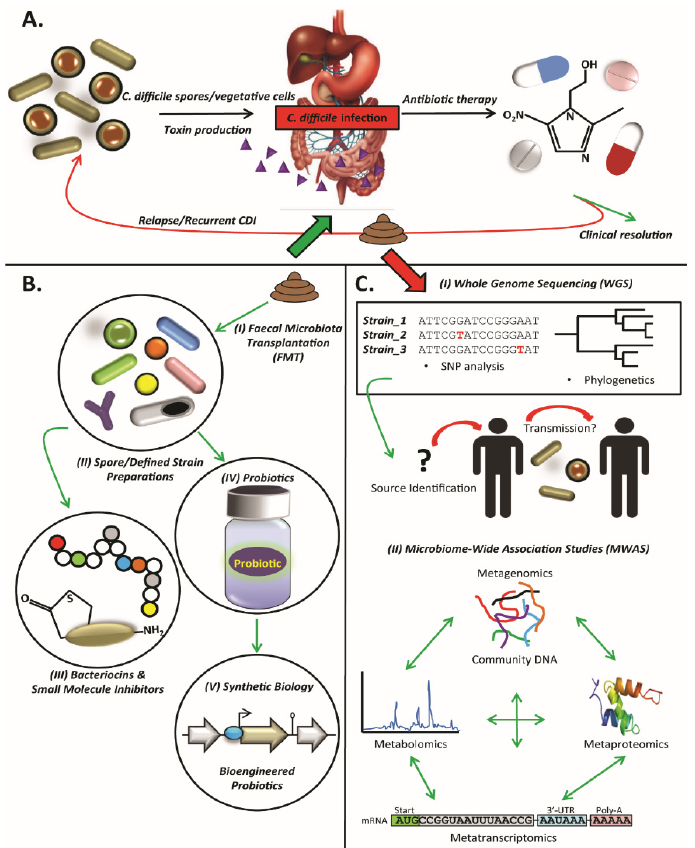
Figure 1. ( A ) Overview of C. difficile infection (CDI). CDI results from ingestion of C. difficile